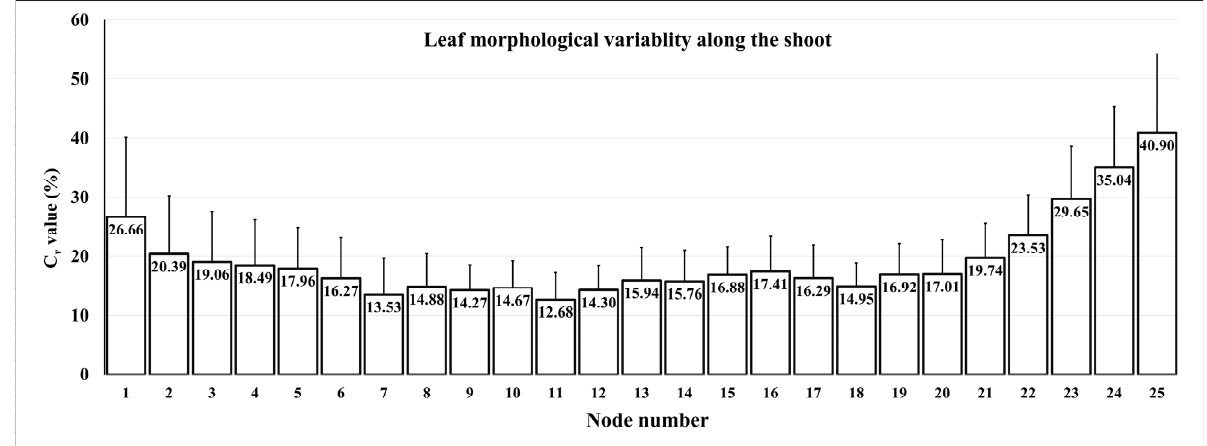
Figure 7. Grapevine ( Vitis vinifera L.) leaves show noticeable variability along the shoot axis. This Figure 7. Mean and standard deviation of the x,y coordinates of 32 landmarks on the leaves along phenomenon was investigated according to 52 morphometric traits and those coefficients of varia ‐ the shoot axis on the 1st, 5th, 10th, 15th, 20th, and 25th nodes (Bodor et. al. [78] with permission from bility (C v ) at each node in Bodor et al. [78] (with permission from the publisher), who found that the samples collected from the 11th node have the lowest variability among 10 shoots.